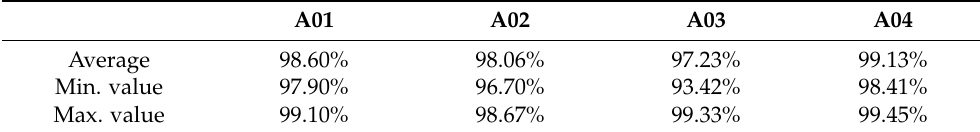
Table 5. Image comparison data from group A.